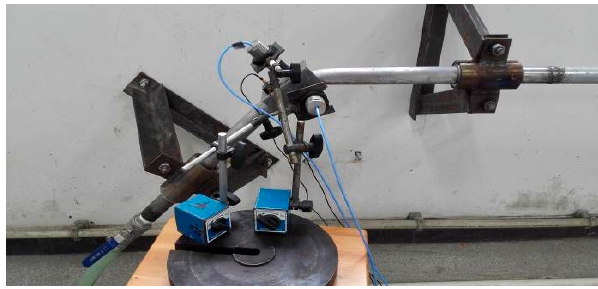
Figure 10. Physical map of pipe vibration test device and stress test device in elbow section.